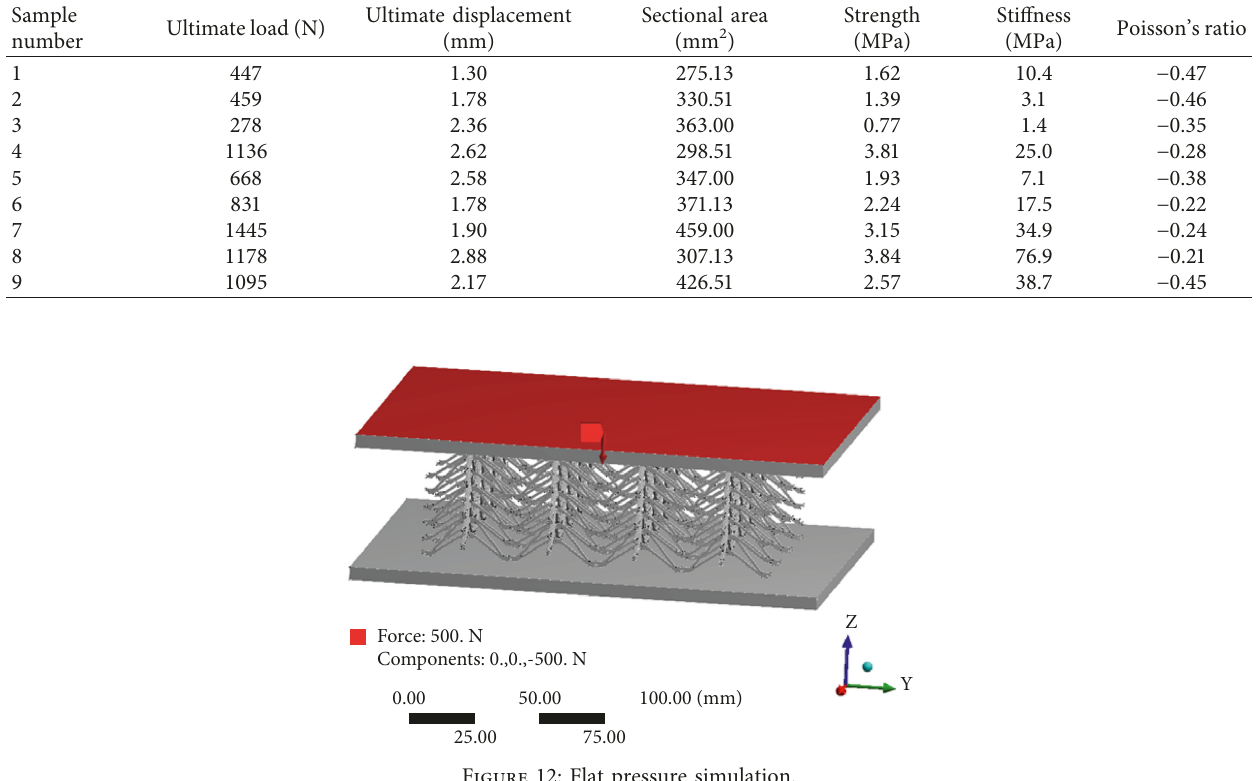
Table 4: Flat crush results for samples.